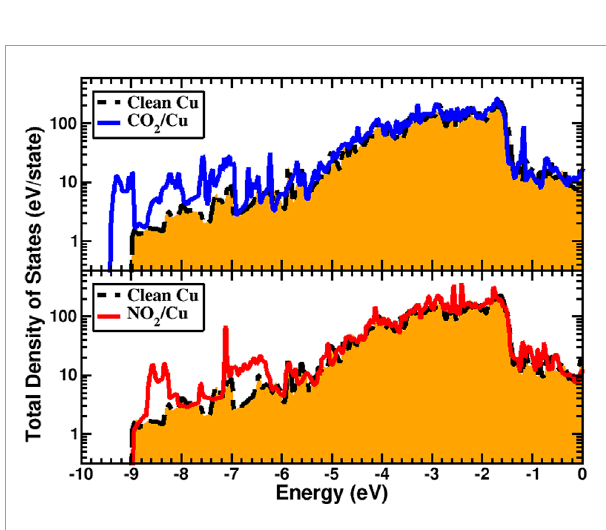
FIGURE 5 Calculated secondary electron yield for the 1.00 ML of NO 2 /Cu (110) (green squares) and CO 2 /Cu (110) (blue diamonds). Experimental measurement for CO 2 /Cu (110) (red triangles) is provided for comparison (Kuzucan, 2011; Kuzucan et al., 2012).